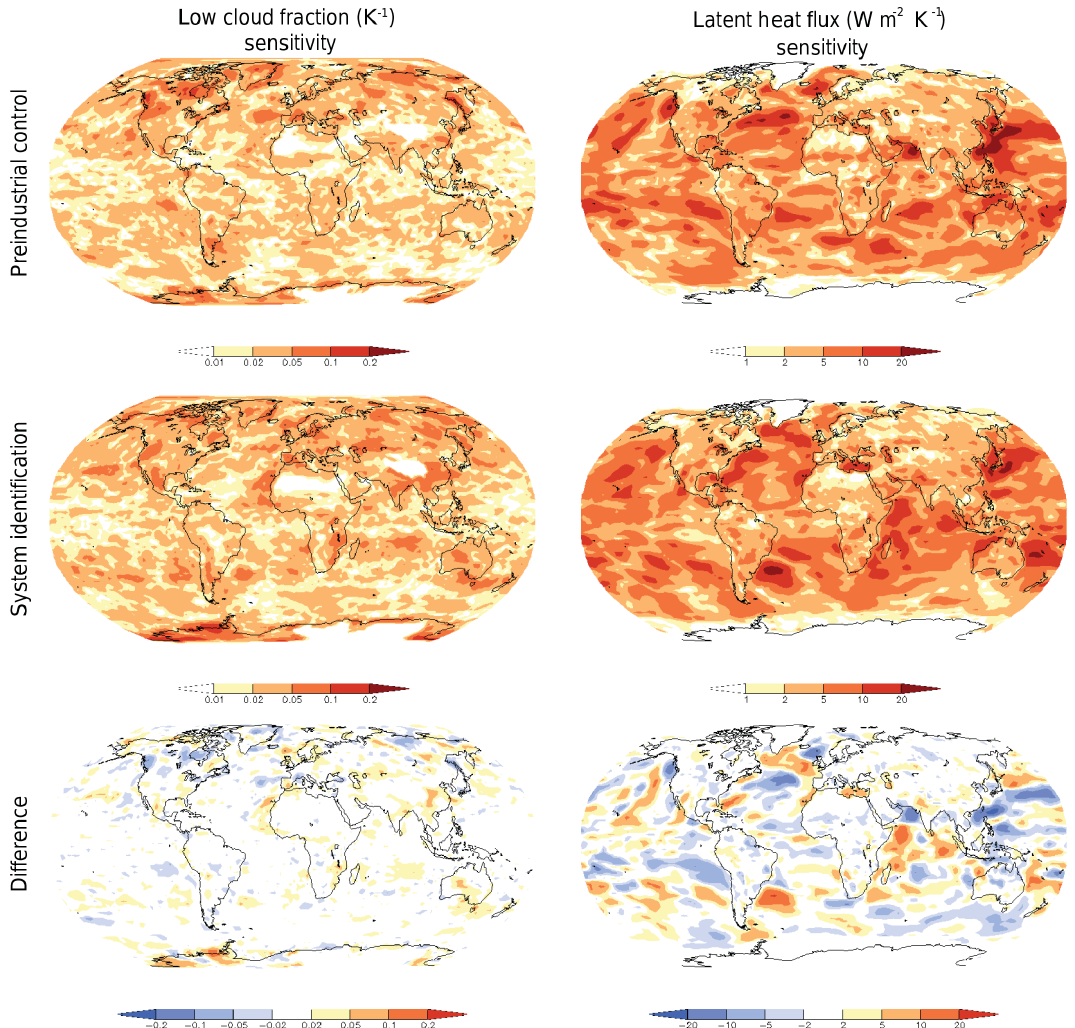
Figure 9. Inter-ensemble standard deviations of the sensitivities of low cloud fraction and latent heat flux. Sensitivities are calculated via projection onto the full sequences that are 7300 days in length. For the control simulation, ensemble members were generated by projecting the control run onto each of the five sequences considered here. Differences are the system identification inter-ensemble standard deviation (middle panels) minus the control inter-ensemble standard deviation (top